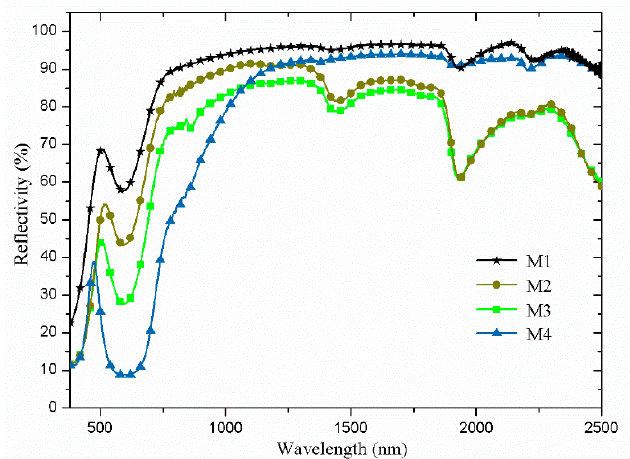
Figure 7. Spectral reflectance profiles of various products.